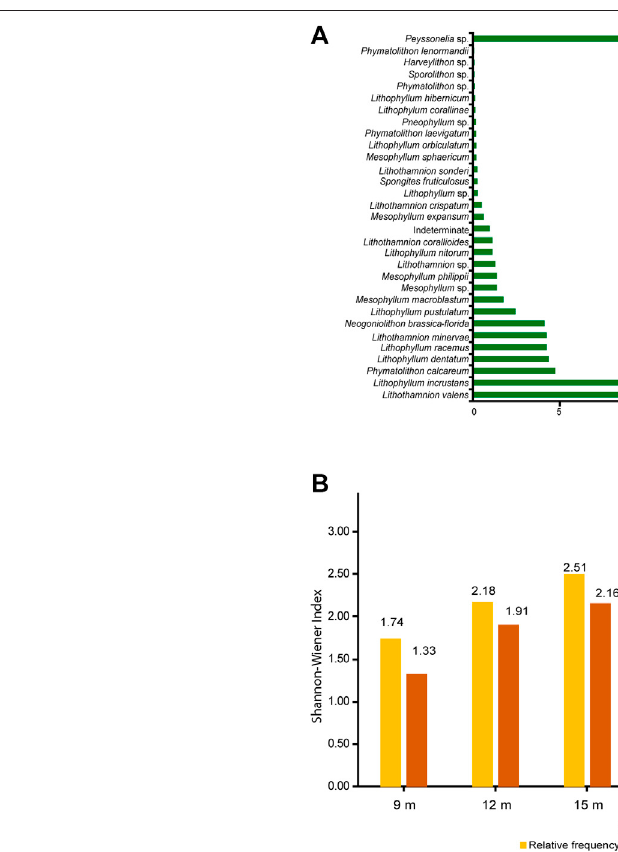
Frontiers in Earth Science |